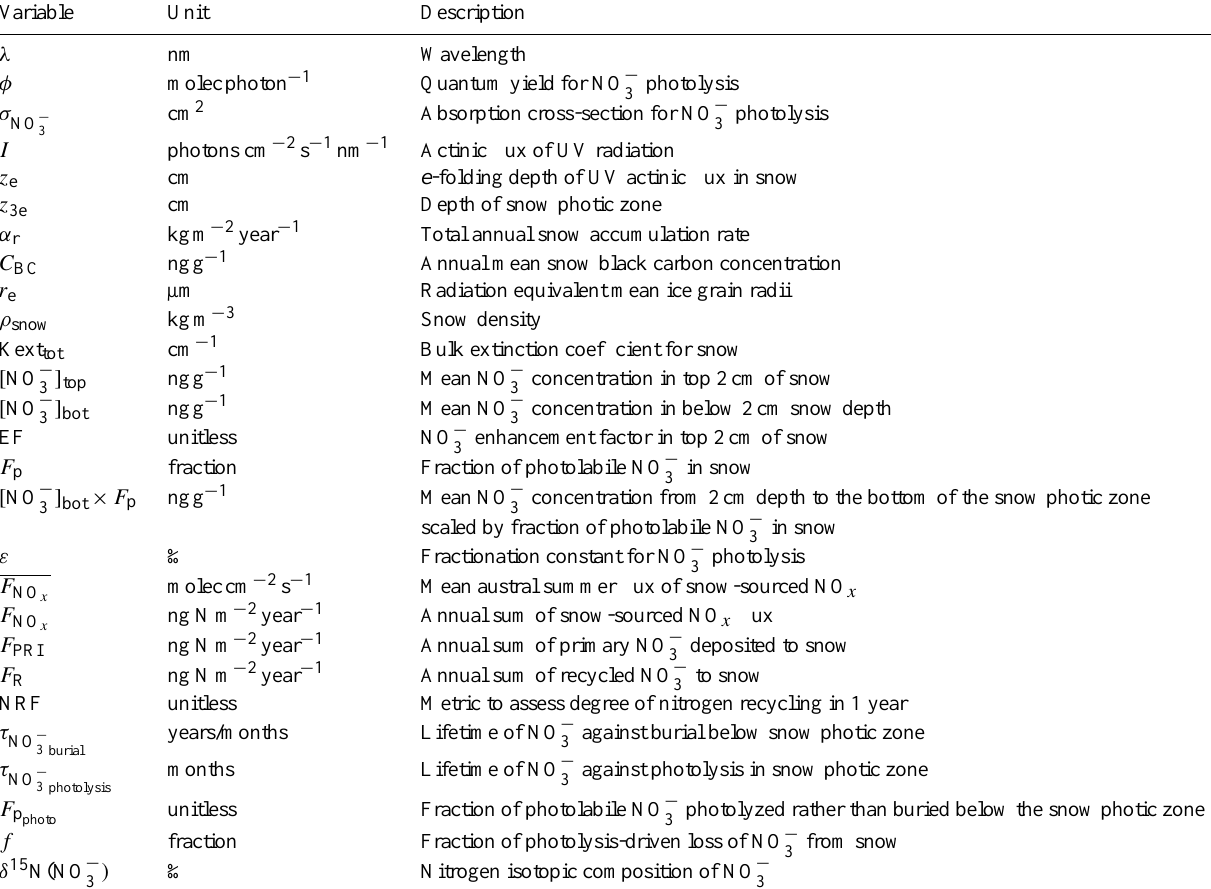
Table 1. Glossary of variables used in this paper.